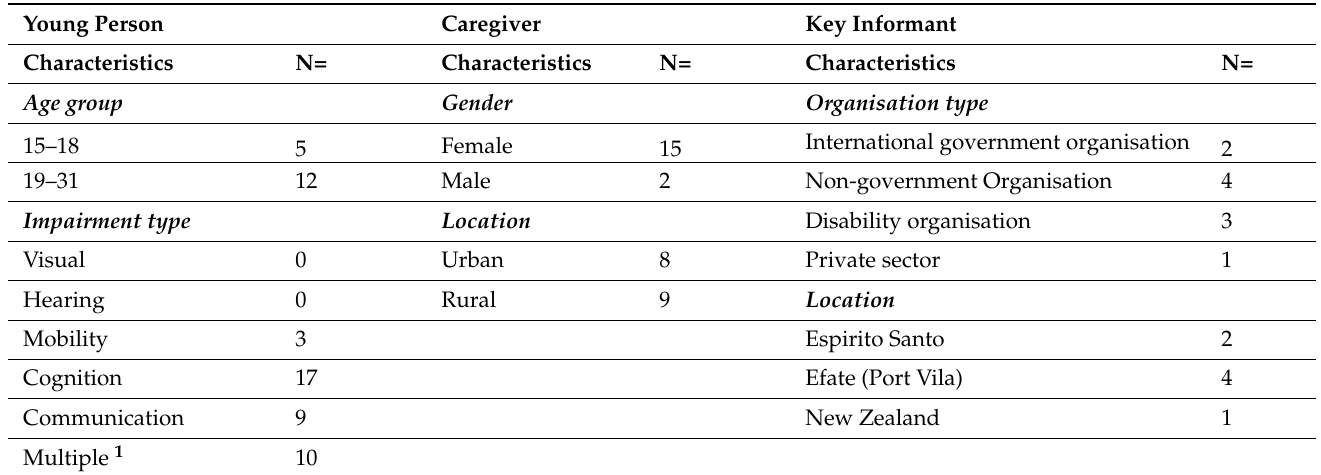
Table 1. Study population